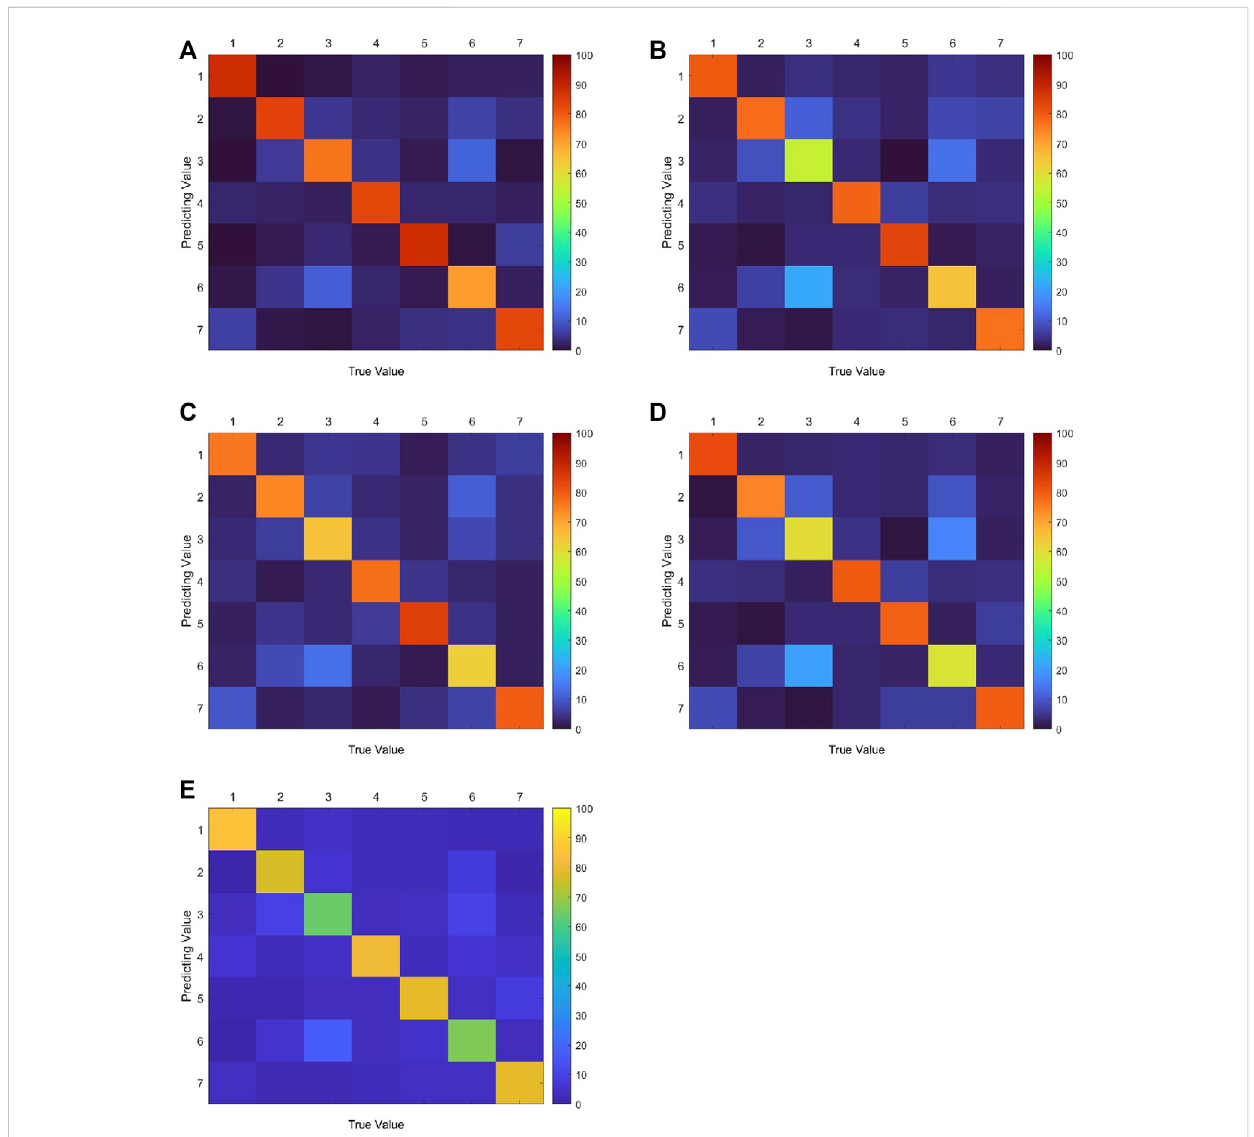
FIGURE 6 Identi fi cation results of different algorithms for the UK-DALE Dataset House 1. (A) MSAM; (B) HMM; (C) Clustering; (D) V-I trajectory; (E) CNN.